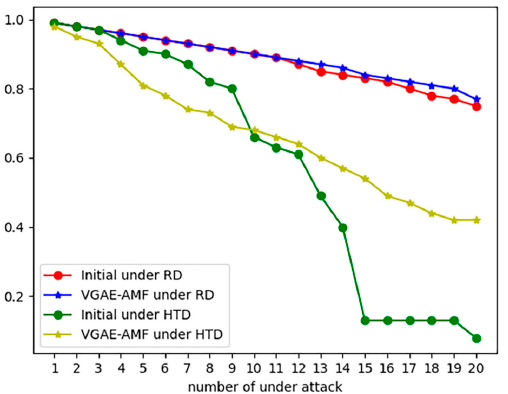
Figure 7. Network connectivity coverage for different types of attacks on the network (RD—Random Attack; HTD—High Threat Degree Attack).